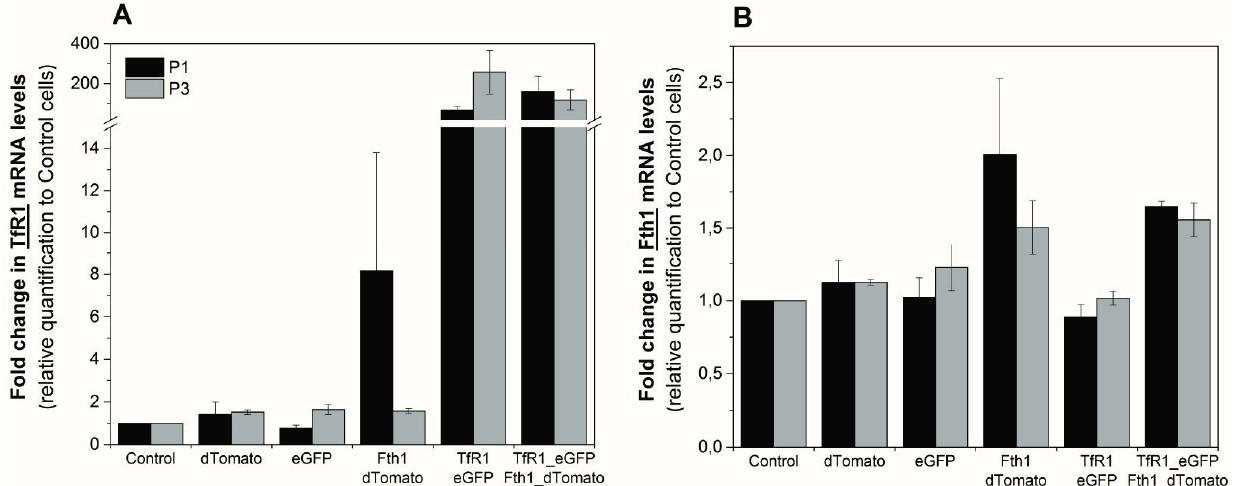
Figure 3. Relative quantification of the reporter gene transcripts at passages 1 and 3 after transduction. Fold change in expression of ( A ) TfR1 or ( B ) Fth1 . Expression levels are relative to control (non-transduced) cells. Error bars represent SEM ( n =